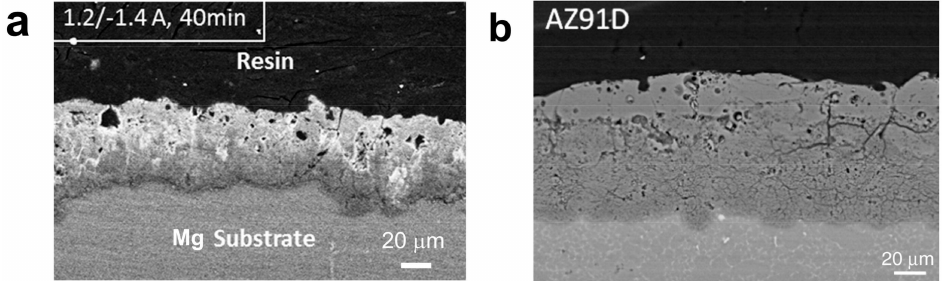
Figure 8. Microstructure features of the PEO coatings on Mg and AZ91D alloy with soft sparking. Cross-sectional images are shown for ( a ) the coating was oxidized on a high purity Mg substrate with R pn = 0.86 in an electrolytic solution of K 2 ZrF 6 , NaOH and Na 6 P 6 O 18 for 40 min [85]; and ( b ) the coating was oxidized on AZ91D substrates with R pn = 0.83 in an electrolytic solution of Na 2 SiO 3 and Na 2 P 2 O 7 for 15 min [86]. Note the pores and fissures near the metal–oxide